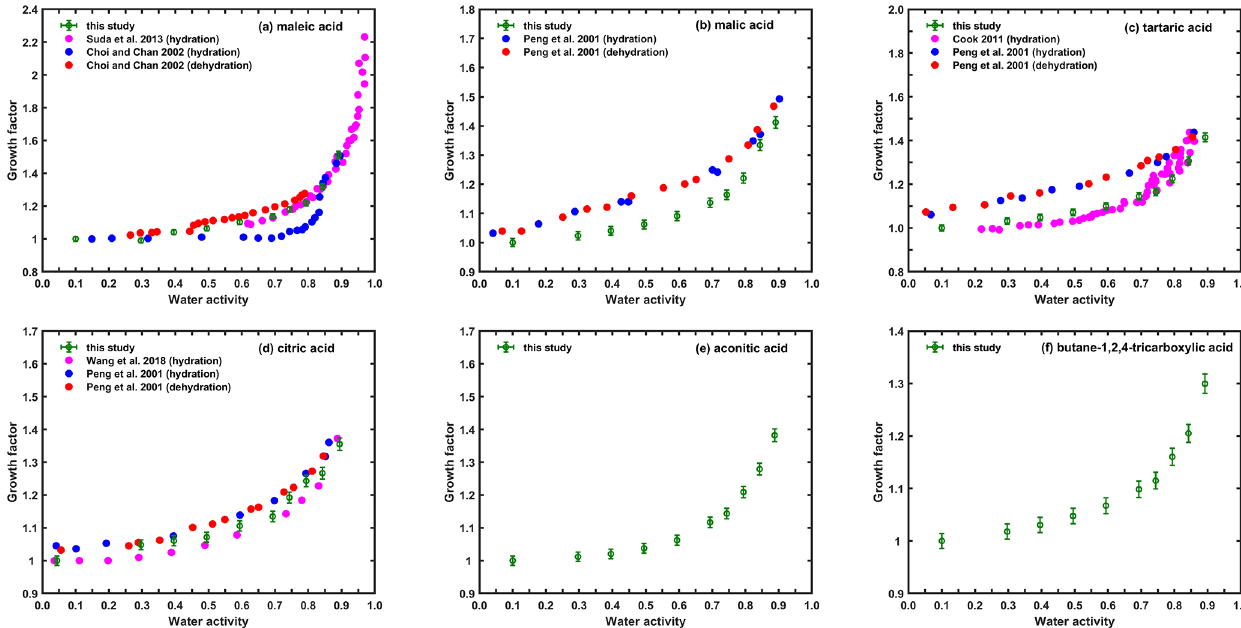
Figure 2. The hygroscopic growth of straight-chain dicarboxylic acid particles with substitutions (a–c) and tricarboxylic acid (d–f) particles (200nm) measured in this study and previous